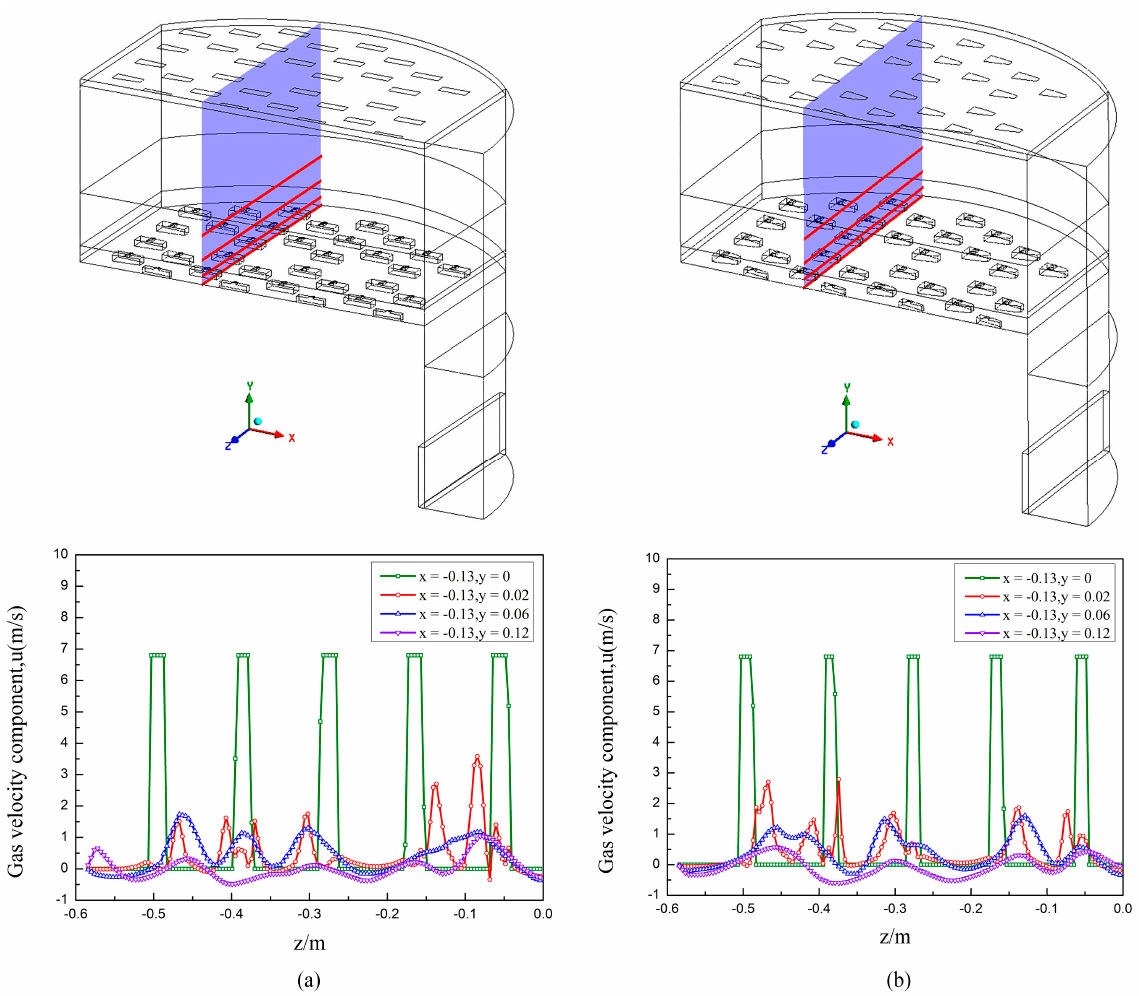
Figure 19. Gas–phase vertical–component velocity at different elevations above tray deck: ( a ) rectangular guided valve tray; ( b ) parabolic–shaped guided valve tray.